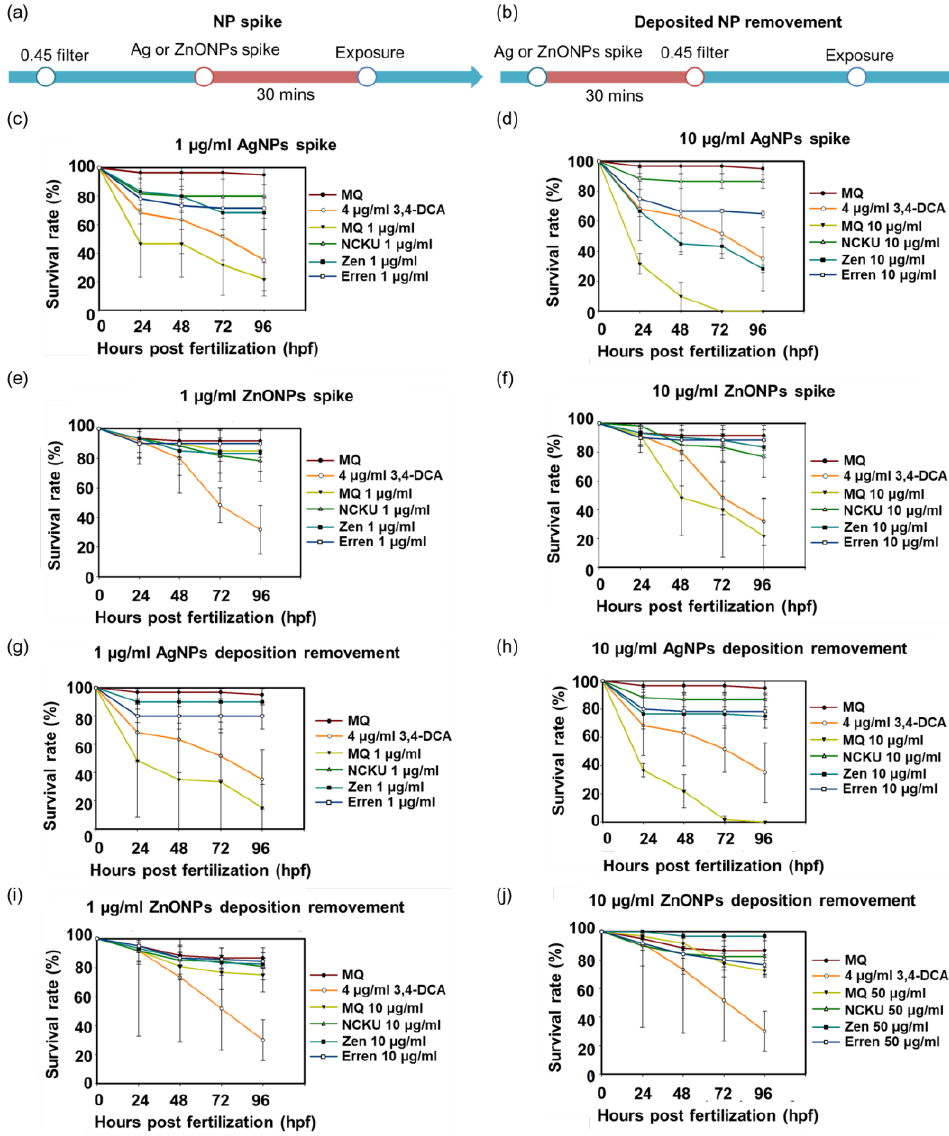
Figure 4. Lethality of AgNPs and ZnONPs spiked in natural water. The study design included two processes: ( a ) NP spiking and ( b ) deposited NP removal. The embryos were treated with ( c ) 1 µg/mL AgNPs, ( d ) 10 µg/mL AgNPs, ( e ) 1 µg/mL ZnONPs, and ( f ) 10 µg/mL ZnONP-spiked natural water. The mortality of embryos exposed to ( g , h ) 1 µg/mL and 10 µg/mL AgNP-spiked water, as well aI ( i , j ) 1 µg/mL and 10 µg/mL ZnONP-spiked natural water in which the aggregates were removed by a 0.45 µ m filter. AgNPs, silver nanoparticles; ZnONPs, zinc oxide nanoparticles; 3,4-DCA,